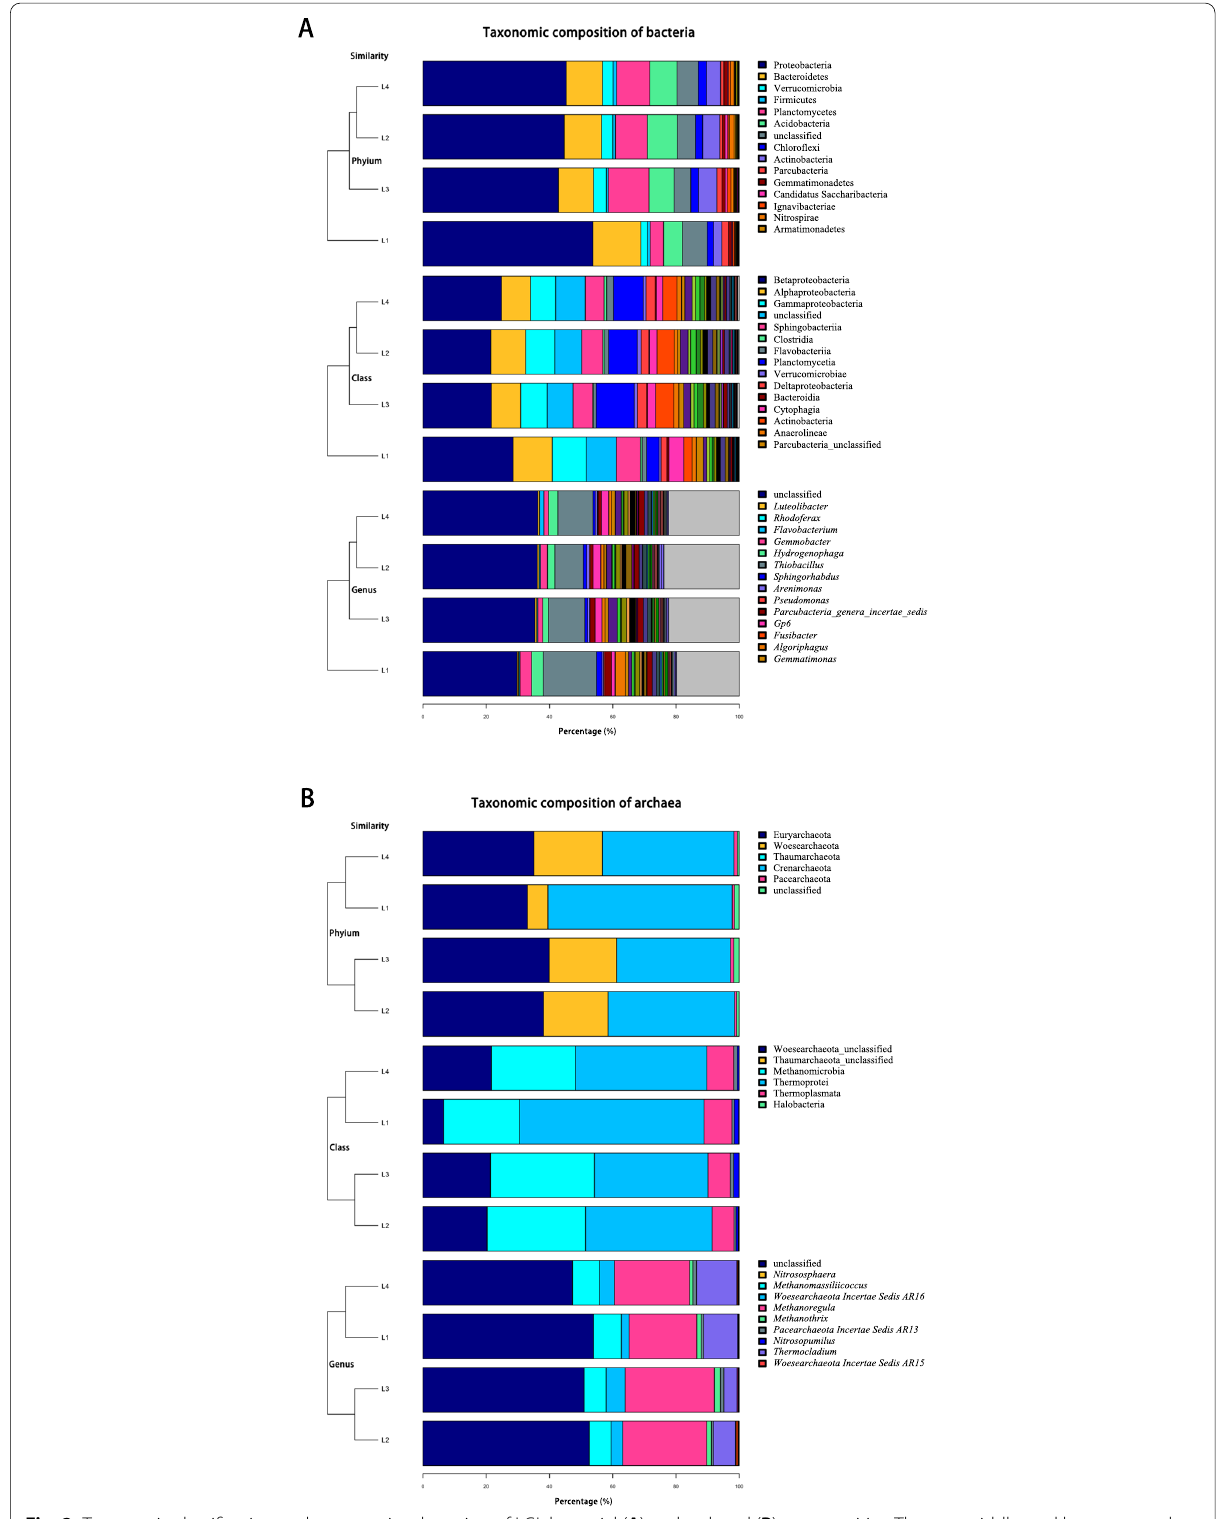
Fig. 2 Taxonomic classification and community clustering of LGL bacterial ( A ) and archaeal ( B ) communities. The top, middle, and bottom panels show taxonomic distributions at the phylum, class, and genus levels,